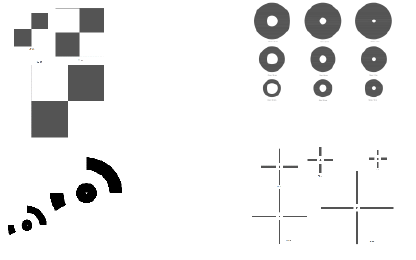
Figure 4. Different tested targets.